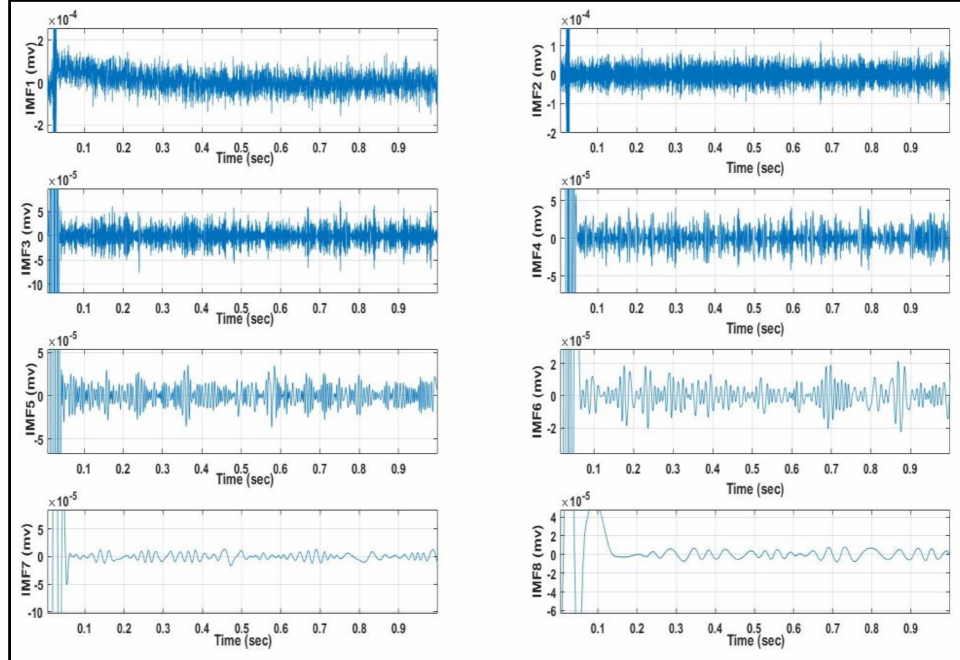
Figure 9. IMFs for a no-leak signal response with water pressure condition of 2